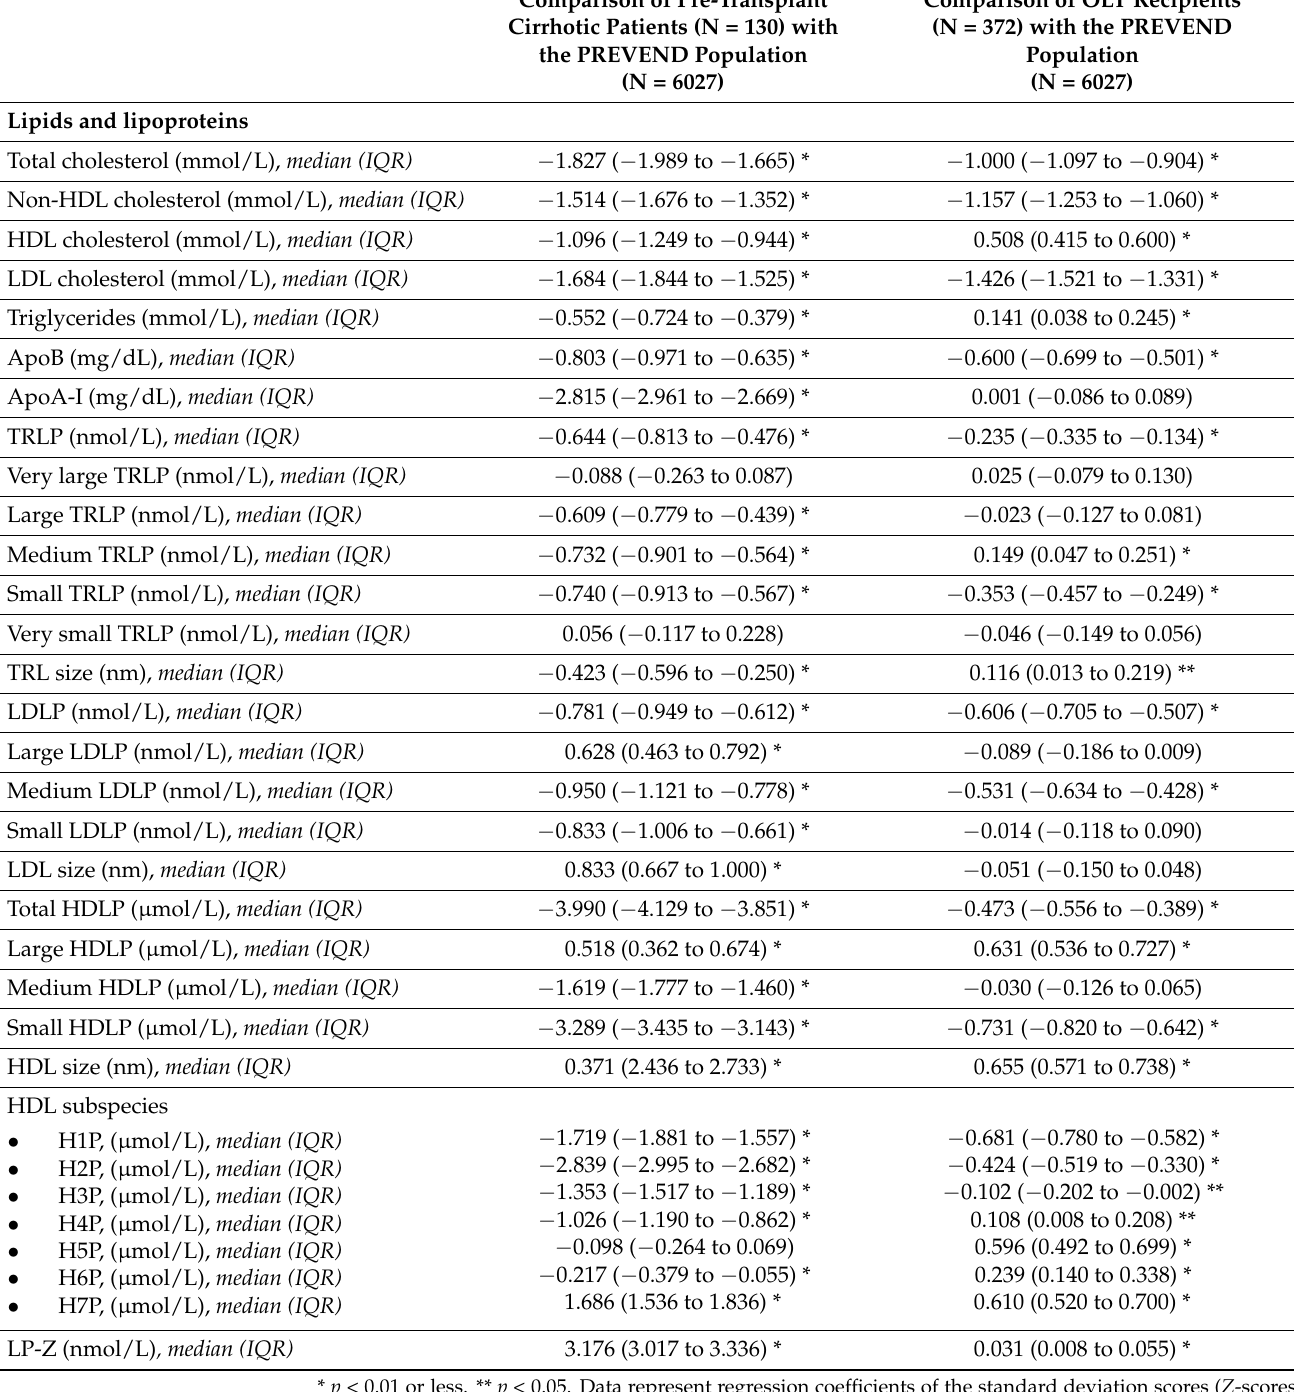
Table 2. Lipid profile of pre-transplant cirrhotic patients and orthotopic liver transplant (OLT) recipients compared with the PREVEND population. Comparison of OLT Recipients Comparison of Pre-Transplant (N = 372) with the PREVEND Cirrhotic Patients (N = 130) with Population the PREVEND Population (N = (N = 6027)